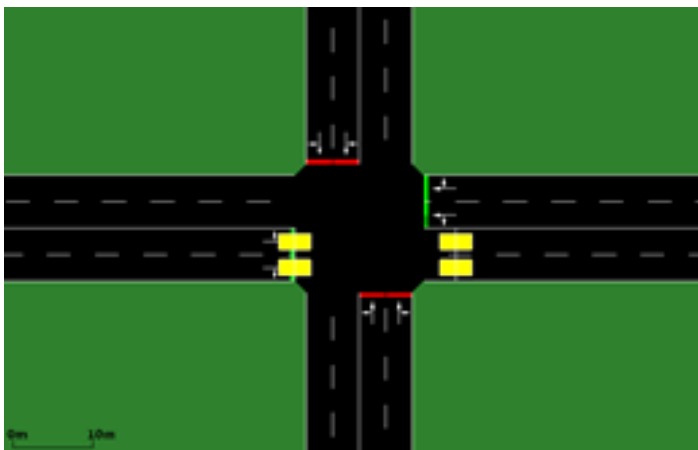
Figure 11. Arterial junction with sensor locations (yellow rectangle).